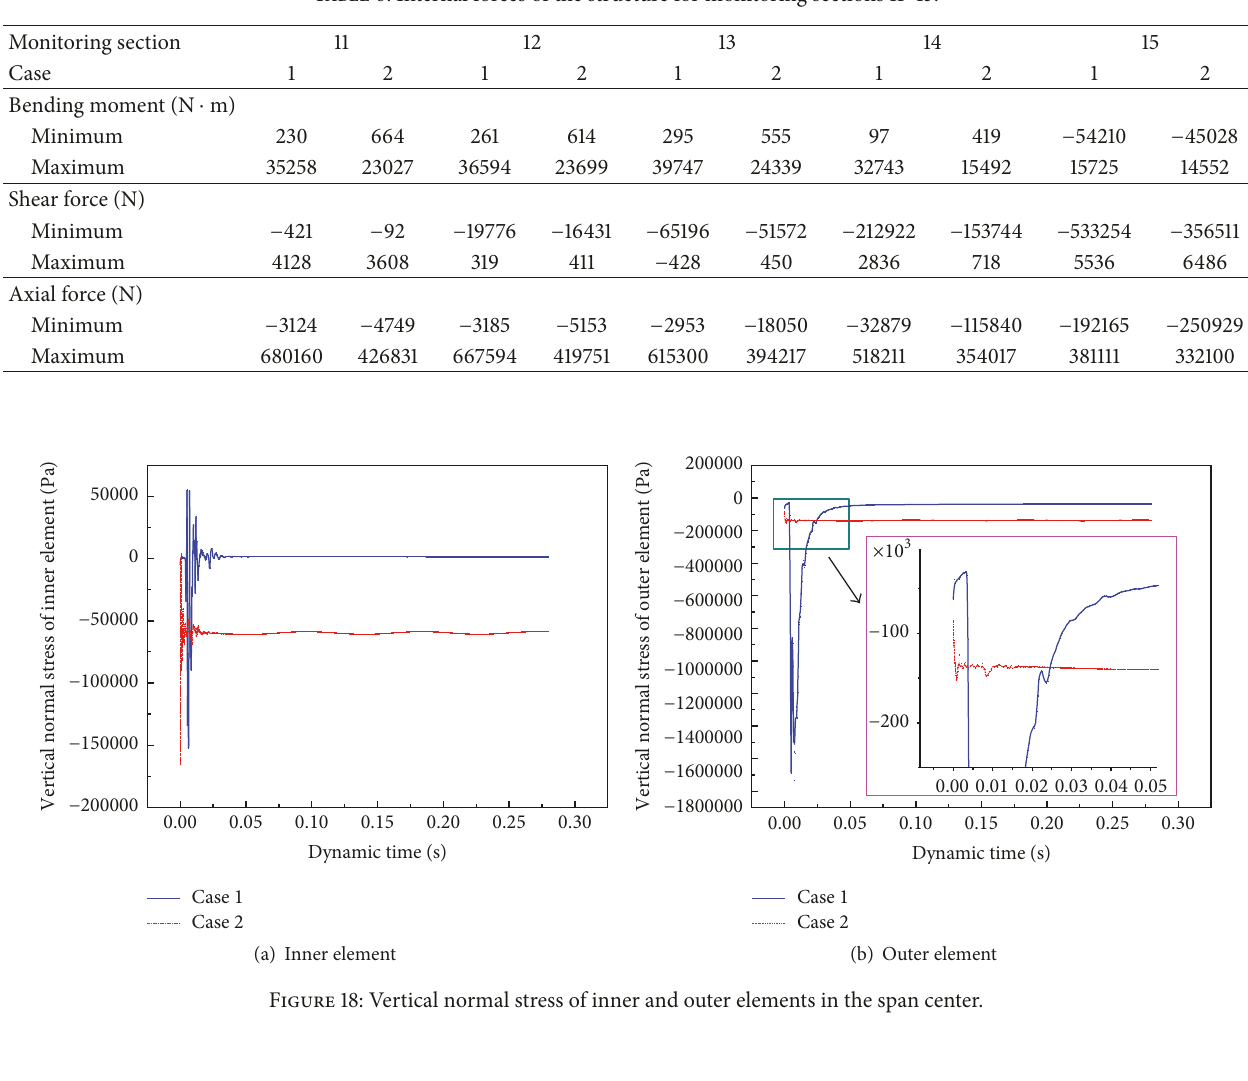
Table 6: Internal forces of the structure for monitoring sections 11–15.